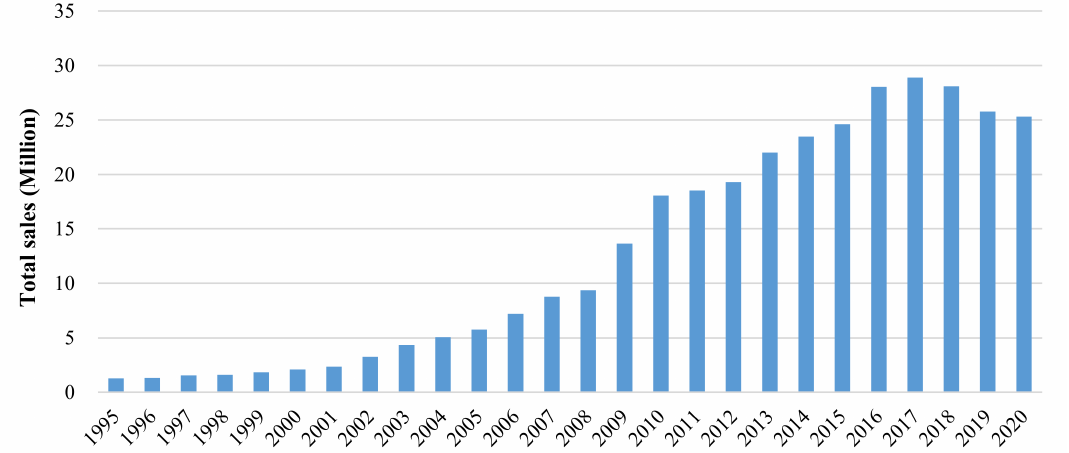
Figure 1. Total automobile sales in China from 1995 to 2020